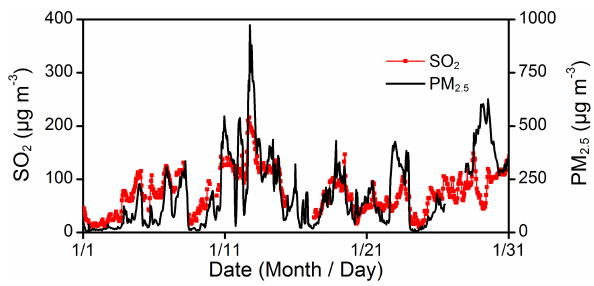
Figure 1. Observed concentrations of SO 2 and PM 2 . 5 during Jan- uary 2013 in